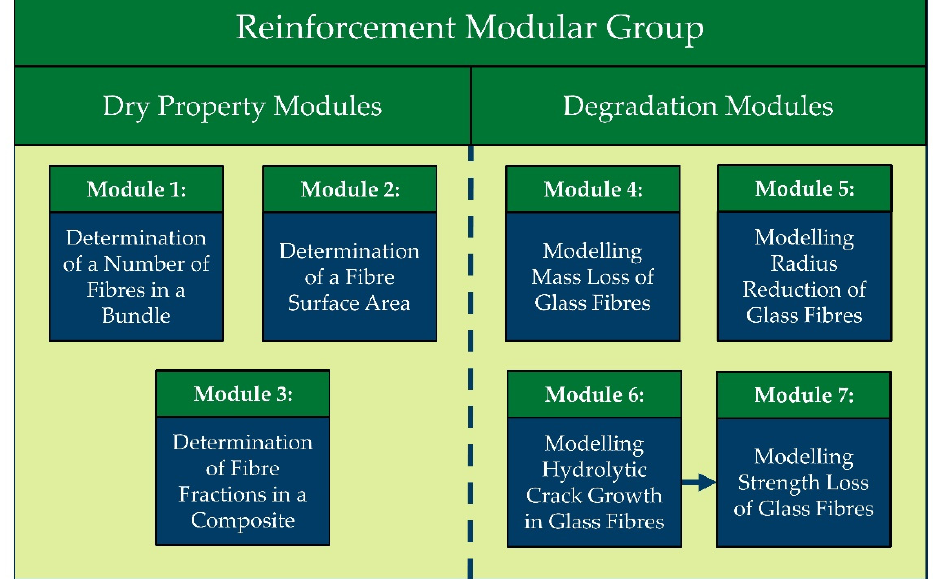
Figure 5. The seven developed modules of the Reinforcement Modular Group within the Modular Paradigm reproduced from [139].